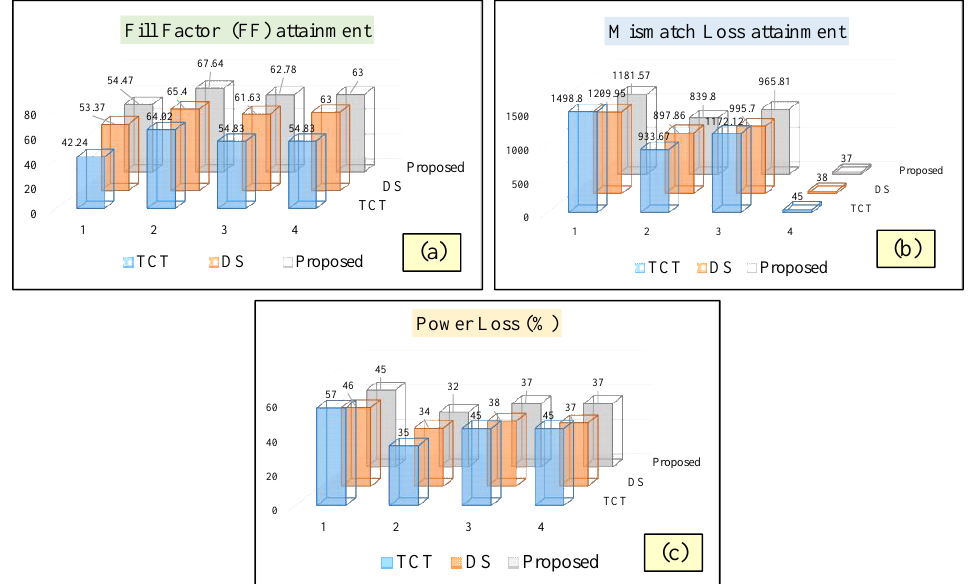
Figure 8. Graphical representation of TCT, DS and the proposed scheme for ( a ) Fill Factor attainment ( b ) Mismatch Loss, and ( c ) Power Loss (%).